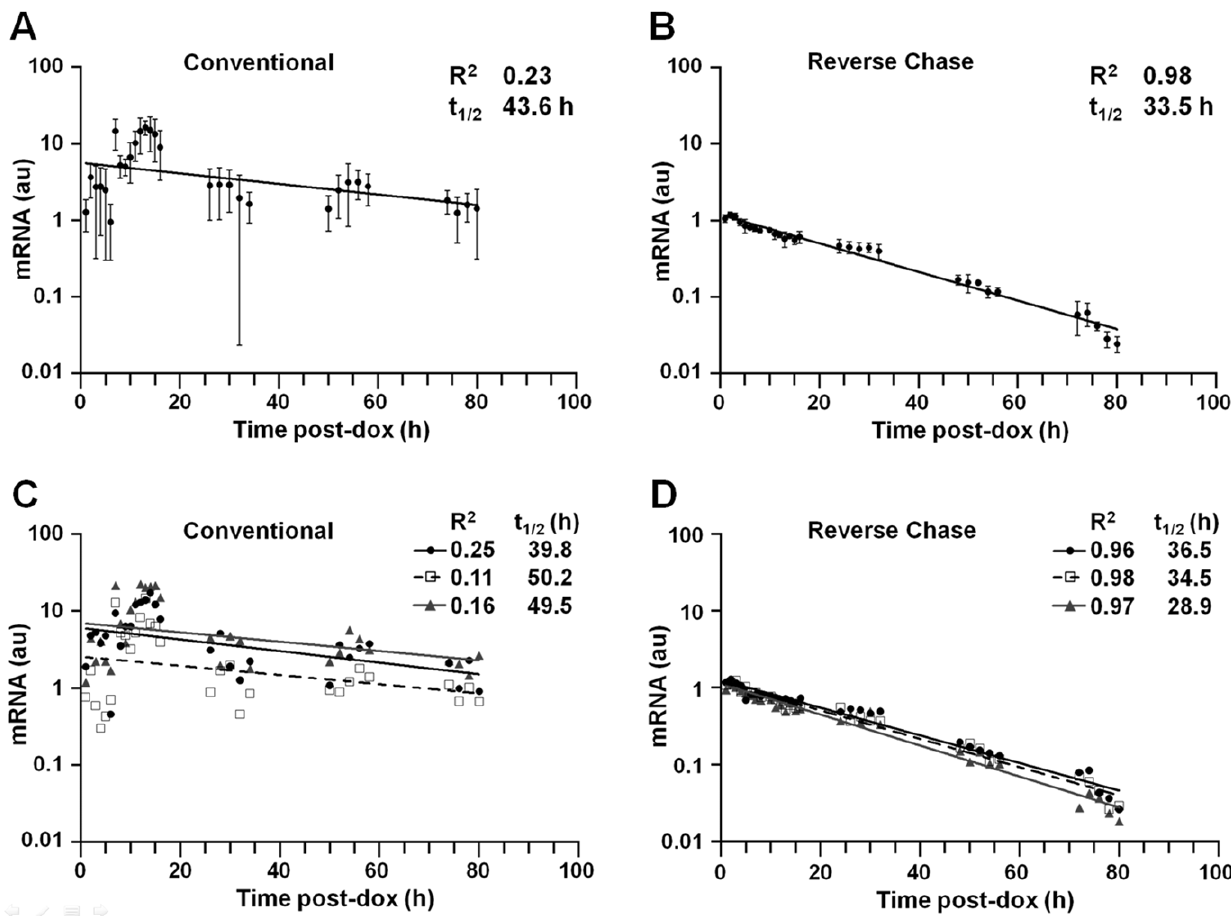
Figure 5. Comparative transcriptional chase analyses of a long-lived test mRNA. (A) Aggregate analysis using the conventional method. Cell aliquots were amended with dox at t 0 , and sacrificed at defined intervals. Levels of b WT mRNA were determined by RT-qPCR relative to control dox-indifferent b -actin mRNA, using the DD Ct method. Normalized RT-qPCR values for b WT mRNA were corrected for aliquot-specific cell numbers, then plotted. Points represent the mean 6 S.D. from three replicate experiments. A t 1/2 value was calculated from the exponential decay constant corresponding to the best-fit curve. (B) Aggregate analysis using the reverse-chase method. Cell aliquots were amended with dox at defined intervals and sacrificed simultaneously at t=80 h. Normalized values for b WT mRNA were determined by RT-qPCR, then plotted. Points represent the mean 6 S.D. from three replicate experiments. A t 1/2 value was calculated from the exponential decay constant corresponding to the best-fit curve, corrected for an expansion factor describing the growth rate of cultured HeLa cells. (C) Analyses of individual replicates using the conventional method. Normalized values for each of three biological replicates reported in panel A were corrected for the number of cells present in each aliquot at the time of sacrifice, and t 1/2 values calculated. (D) Analyses of individual replicates using the reverse-chase method. Normalized values for each of three biological replicates reported in panel B were directly plotted, and t 1/2 values calculated following correction for interval cell expansion.